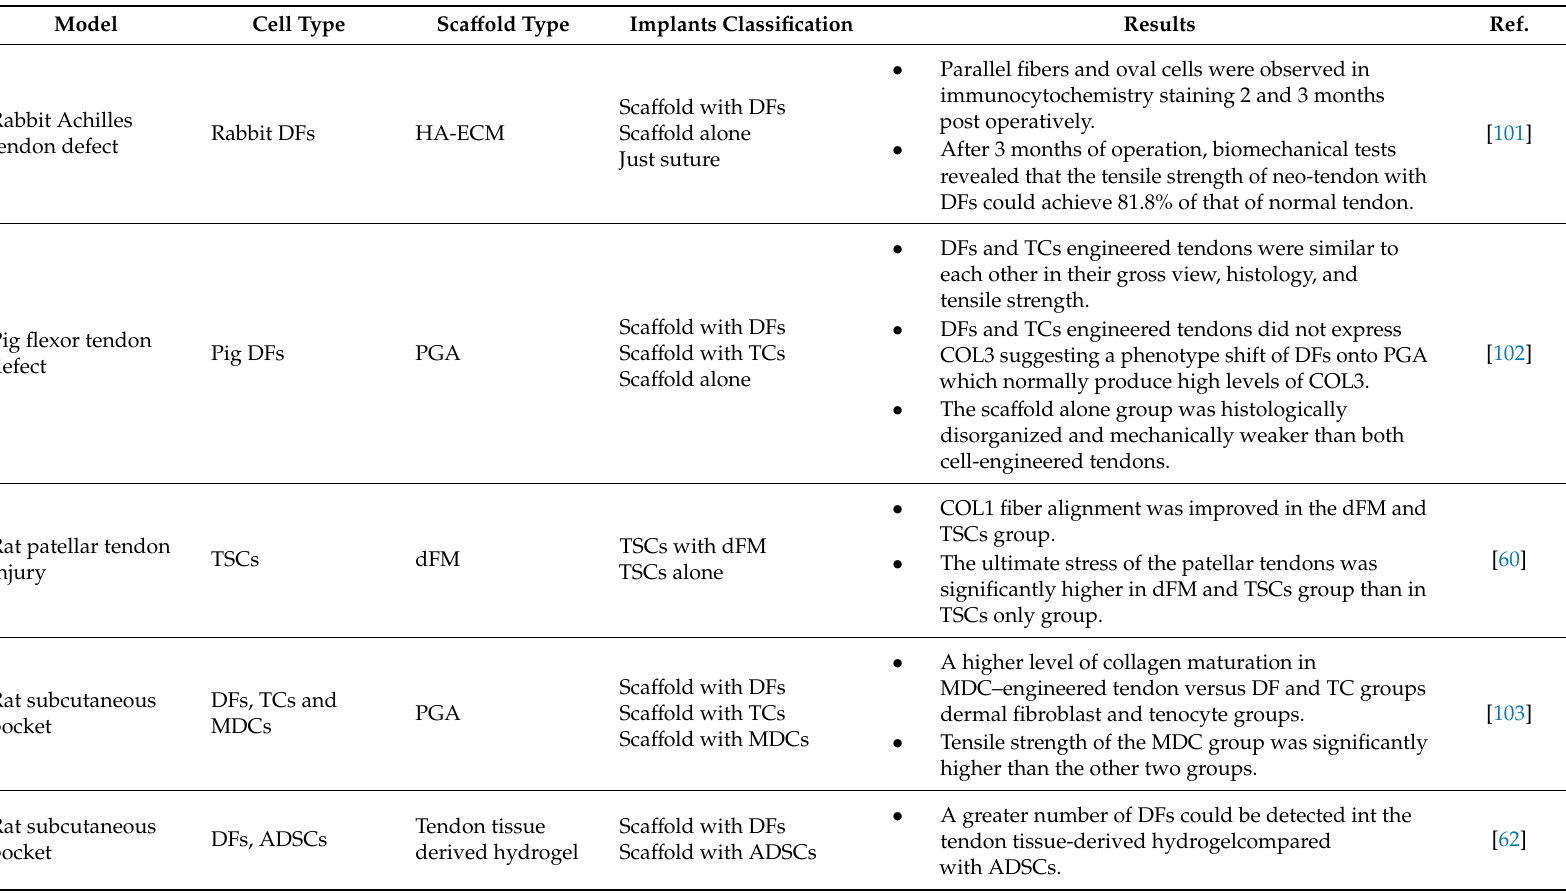
Table 3. In vivo studies on tenogenic potential of DFs (in chronological